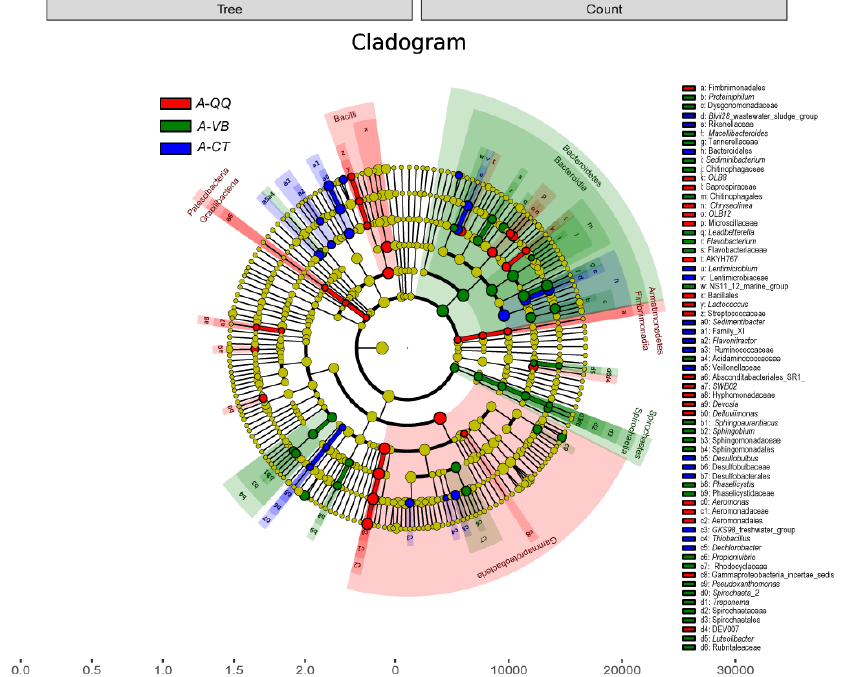
Figure 9. Plot of cladogram from linear discriminant analysis (LDA) e ff ect size (LEfSe) analysis of activated sludge depicting the taxonomic levels represented by rings (from inside to outside: phyla to genera). Each circle is a member within each level. The size of each circle is proportional to RA. Taxa at each level showed a significant di ff erence in abundance. Red-QQ beads (A-QQ); green-vacant beads (A-VB); blue-no beads control